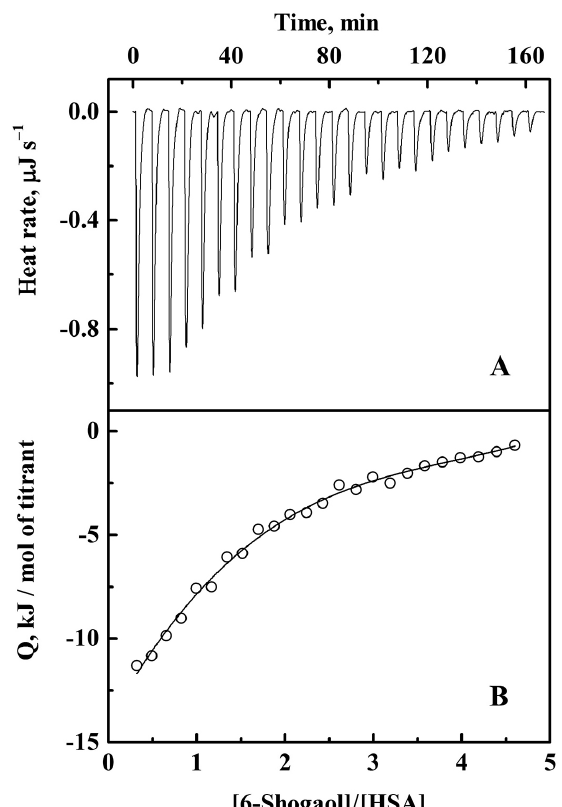
FIGURE 2 - (A) Calorimetric response to successive injections of 6-shogaol (380 µM) into HSA (25 µM). (B) Integrated plot of the amount of heat liberated ( Q ) per injection as a function of the 6-shogaol/HSA molar